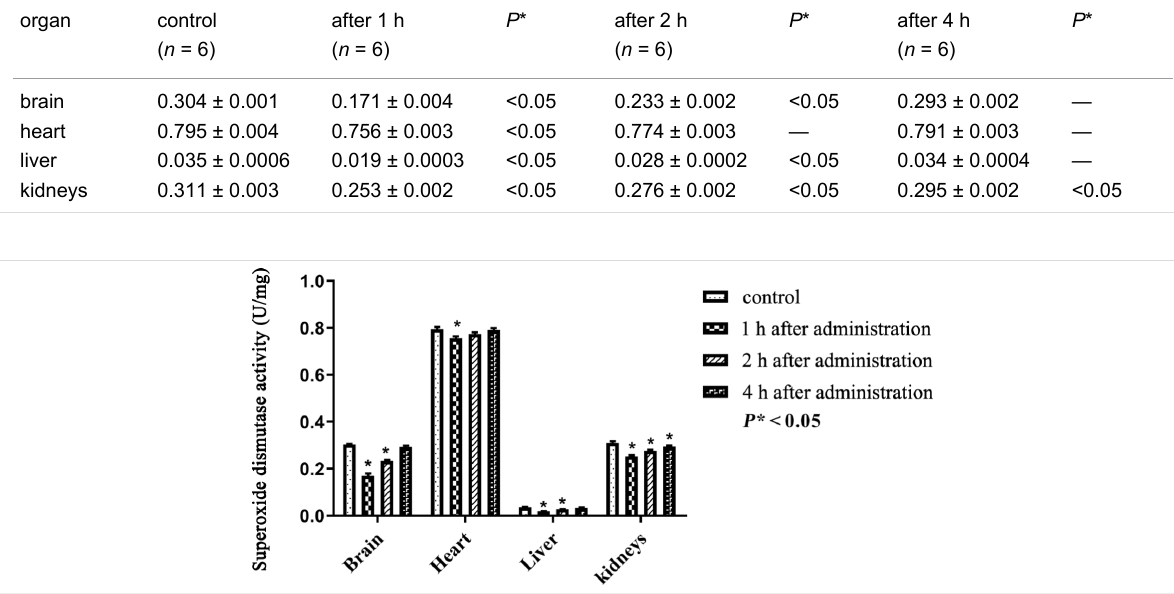
Figure 8: Superoxide dismutase activity after intraperitoneal administration of PEG-nGO, error bars: one standard deviation.